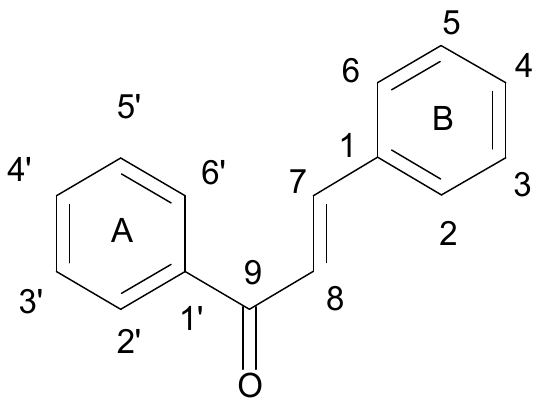
Figure 1. Chemical structure of chalcone.